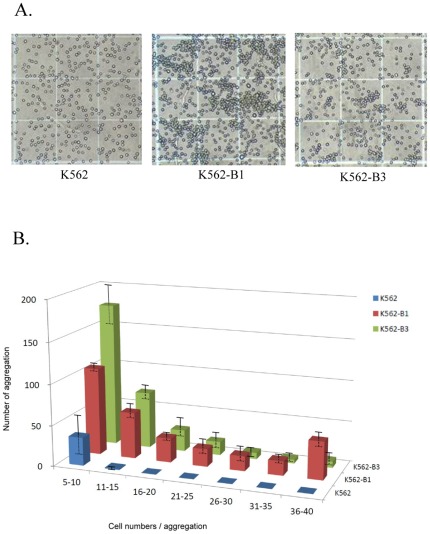
Expression of B3 cDNA is sufficient to induce typical mixed-field agglutination.A. The indicated K562 sublines were treated with sodium butyrate to induce erythroid differentiation. The cells were then incubated with anti-B antibody and cell agglutination was observed using a phase contrast microscope. B. The numbers of aggregation with the indicated number of cells/aggregate were counted. Histogram for the agglutination size distribution was shown. The data represent the mean ± S.D. of three independent experiments. P<0.001 by Kruskal-Wallis test.